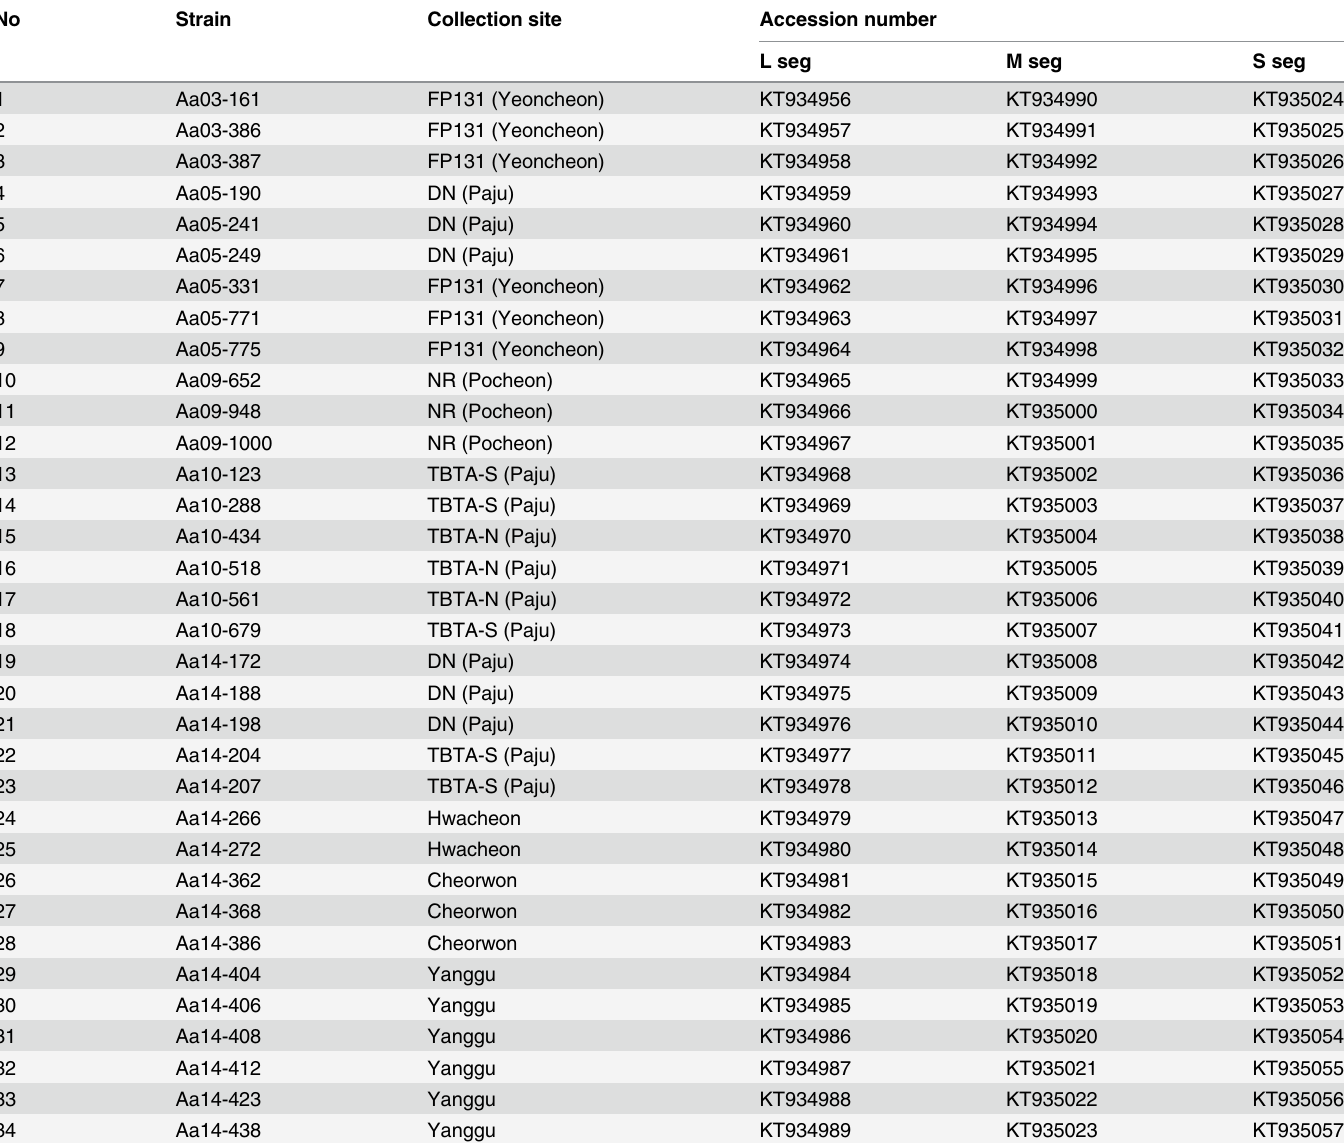
Table 2. Accession number of the whole genome sequences of HTNV collected from Gyeonggi and Gangwon provinces.